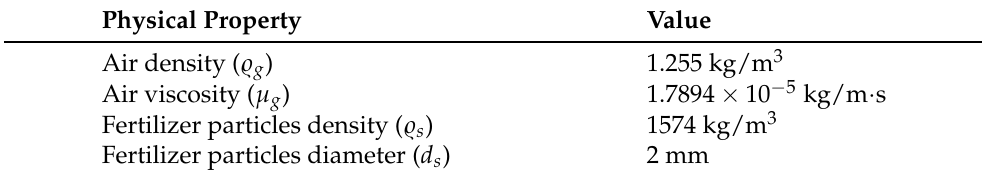
Table 1. Physical properties of the simulations.